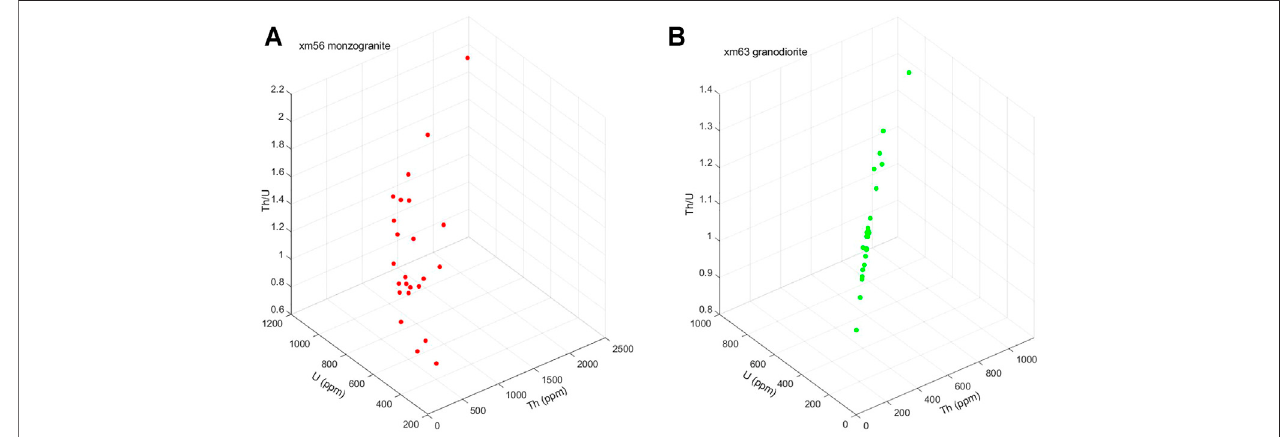
FIGURE 8 | Diagrams of zircon Th, U, and Th/U ratios. (A) Zircon grains from sample xm56 monzogranite in the Caina intrusive complex of the Quxu batholith. (B) Zircon grains from sample xm63 granodiorite in the Caina intrusive complex, Quxu batholith.